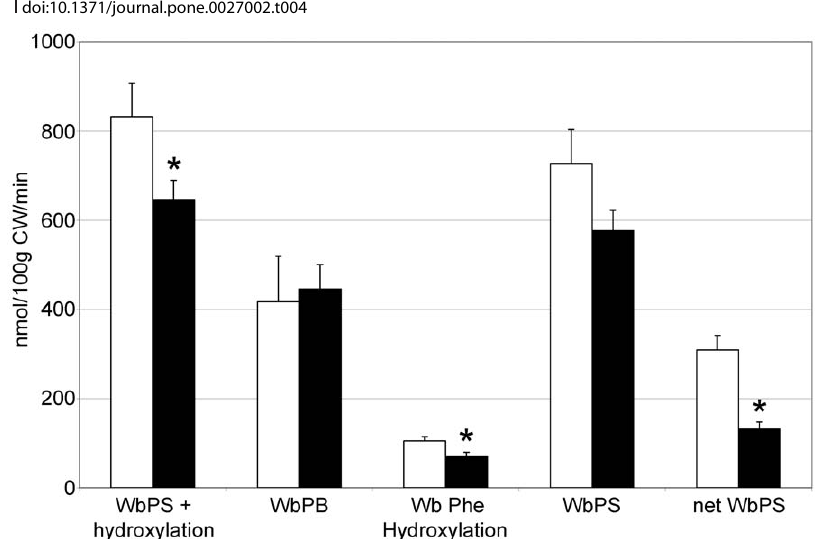
Figure 2. Effect of aging on whole-body protein kinetics at the fed state. % adult rats and & old rats. Values are expressed as means 6 SEM. P , 0.05 vs . adult group (Student’s t -test). CW=carcass weight. WbPS=whole-body protein synthesis; WbPB=whole-body protein